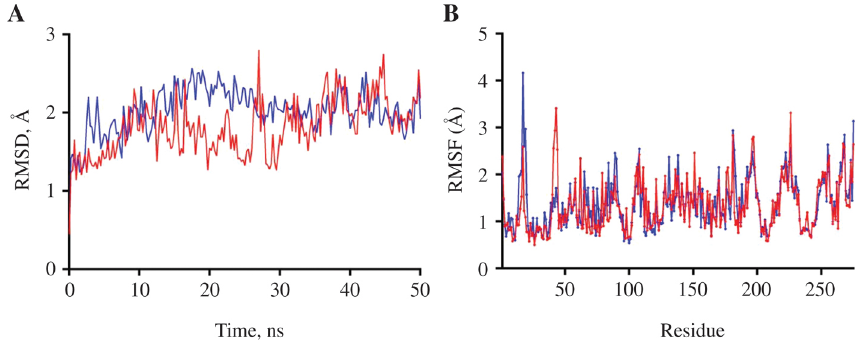
Figure 4: (A) RMSD values of C α atoms and (B) RMSF values of residues in chain A of ALQTGITLV-4PRN (red) and VPSSSTPL-3OX8 (blue)